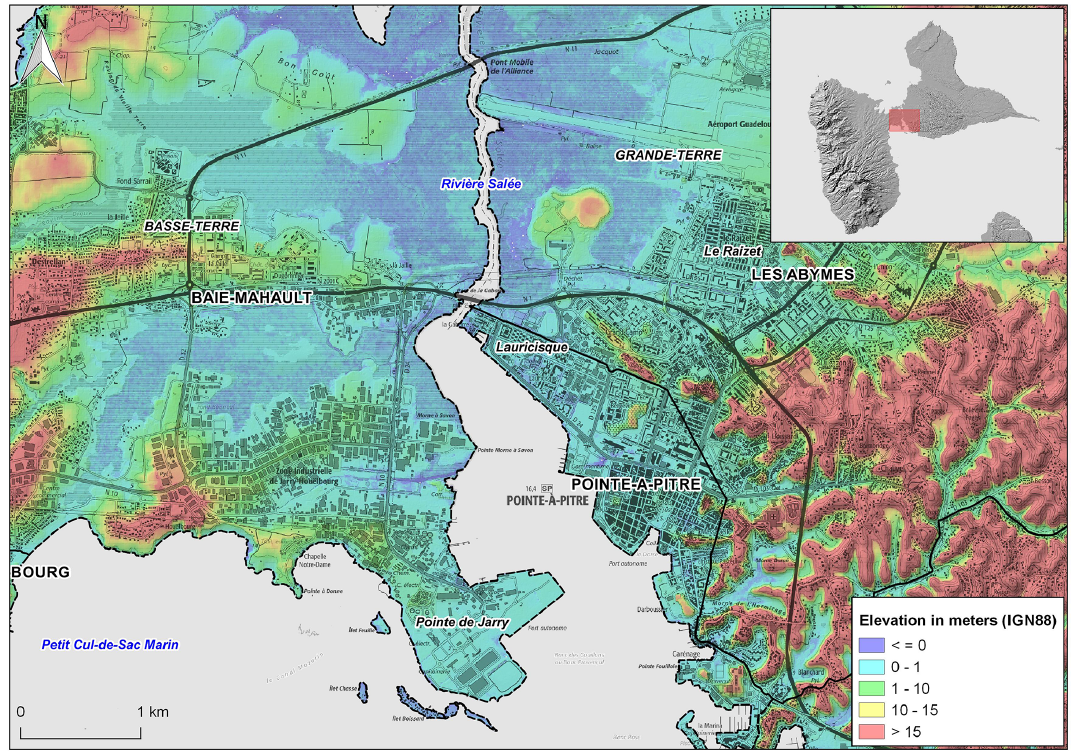
Figure 1. The Petit Cul-de-sac marin area in Guadeloupe, showing urbanized areas and altitudes (map created by BRGM; data: IGN, SHOM; © BRGM, IGN,